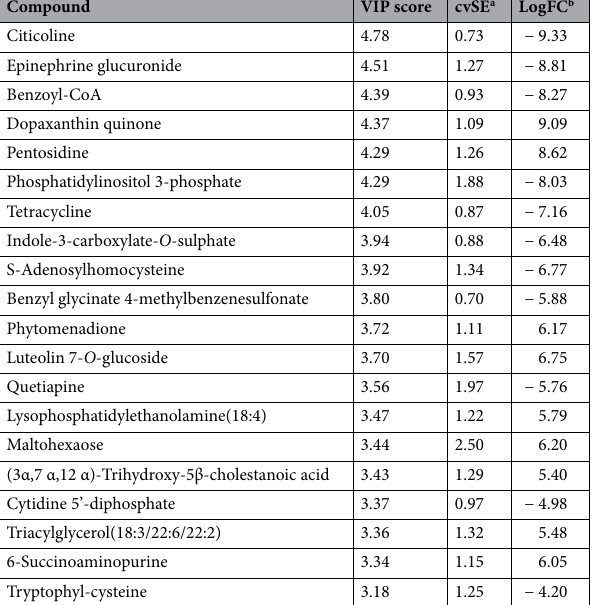
Table 1. Most discriminant compounds (according to variable importance in projection [VIP]) between plasma samples collected before ( ‒ 7 and 0 days from dry-off [DFD]) or after dry-off (7 DFD). a cvSE, cross- validation standard error. b LogFC, logarithm of Fold-Change